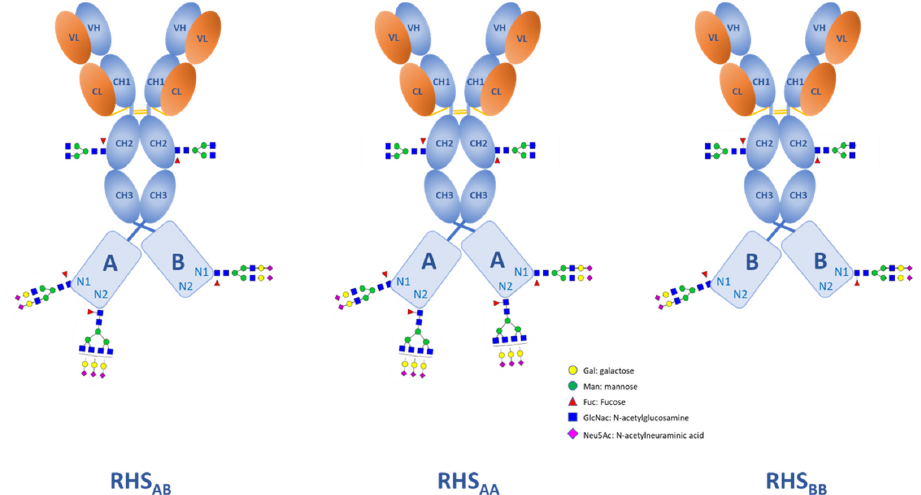
Figure 3. Macro-heterogeneities resulting from the partial site occupancy of the N2 site (ordered according to their expected abundance.